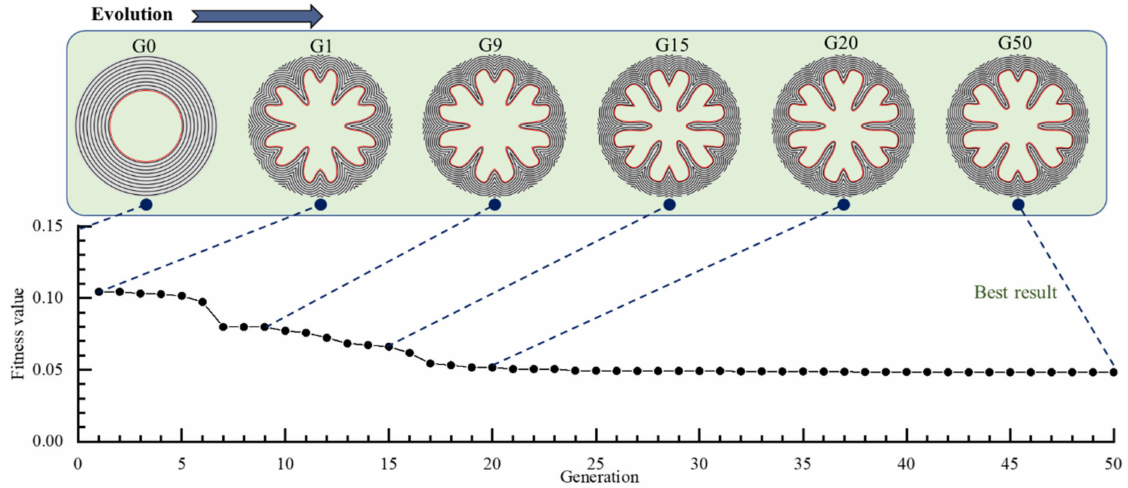
Figure 26. Evolution of the designed dual-thrust grain.